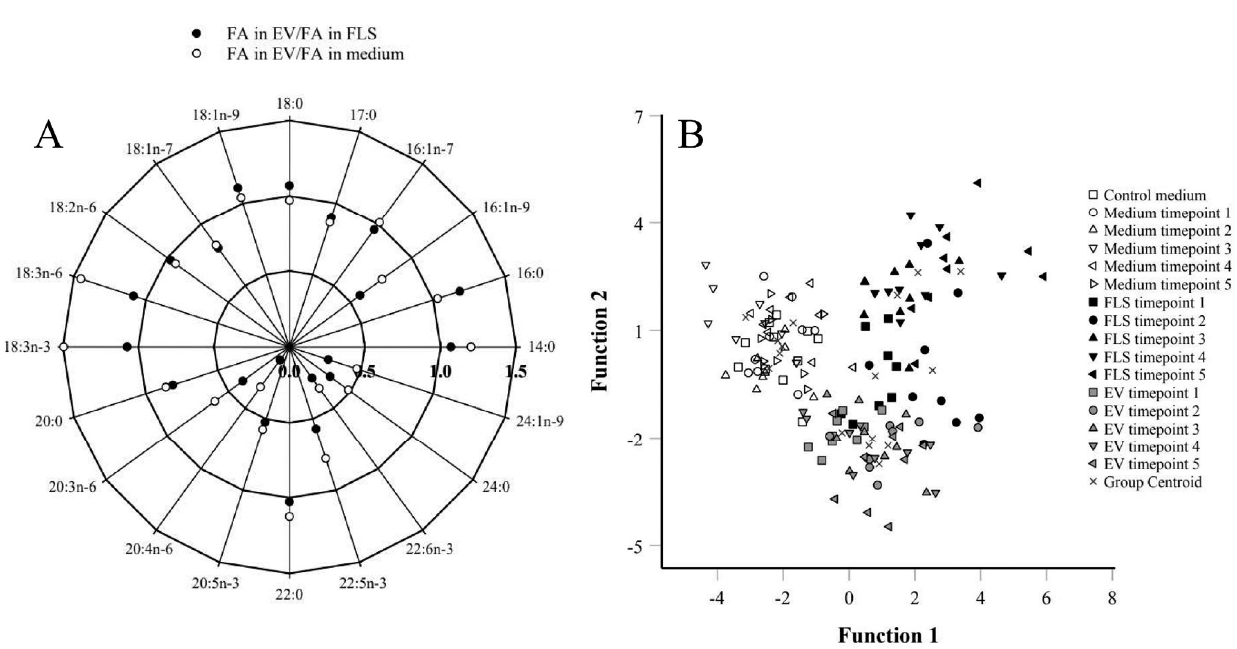
Figure 6. The plot of the fractionation coefficients of selected fatty acids (FAs) in extracellular vesicles (EVs) vs. fibroblast-like synoviocytes (FLSs) (●) or in EVs vs. FLS-conditioned media ( ○ ) (panel ( A )). Values <1.0 indicate that the mol-% of a given FA is higher in FLSs or media than in EVs and values >1.0 indicate that the mol-% is higher in EVs than in FLSs or media. Discriminant analysis of FA proportions in control and FLS-conditioned media, FLSs, and EVs collected during 5 different timepoints: 1 = lag phase, 2–3 = proliferating cells, 4–5 = high-density cells (panel ( B )). Function 1 (on x -axis) explained 58.5% of the variance in the dataset and function 2 (on y -axis) 41.5% of the variance. White symbols = media, black symbols = FLSs, grey symbols = EVs.